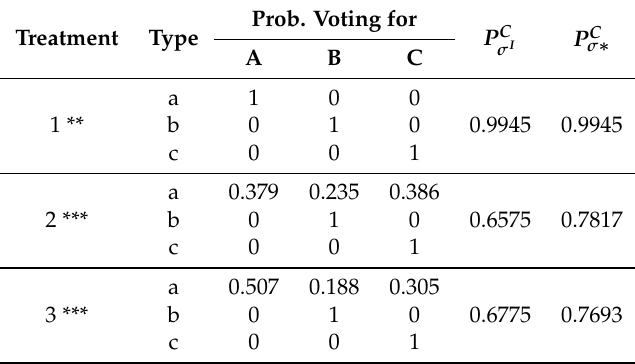
Table 2. Predicted strategies by type: **analytical, ***numerical. Prob. Voting Treatment Type